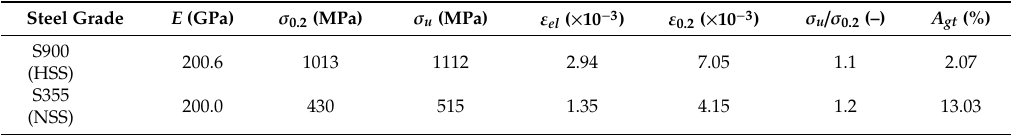
Table 2. Averaged mechanical properties of the